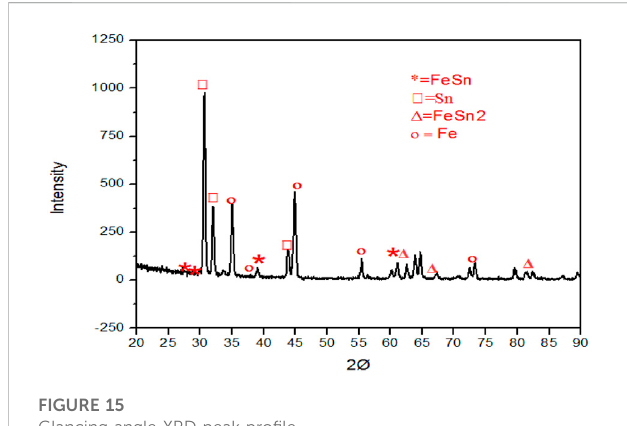
FIGURE 15 Glancing angle XRD peak pro fi